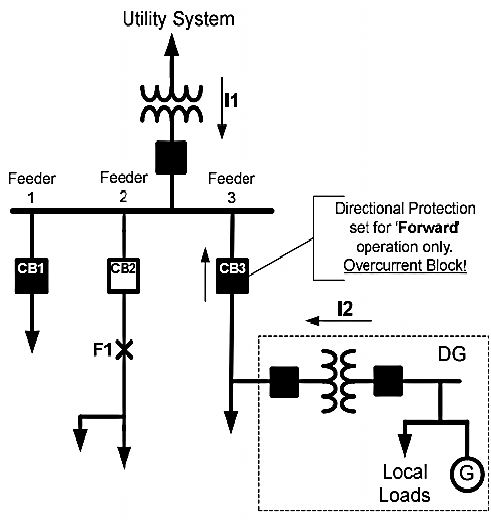
Figure 5. Example of advantage of DOCR at CB3 in preventing from tripping due to a fault from feeder No. 2.